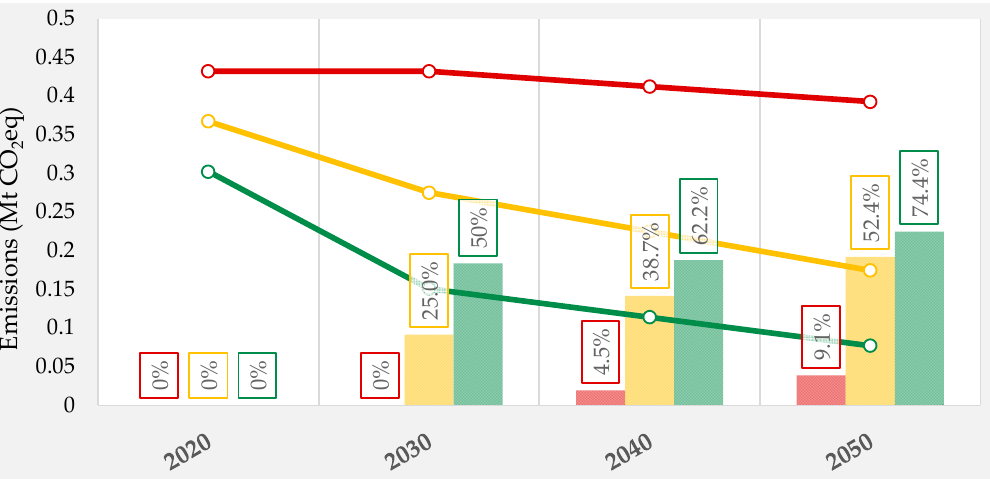
Figure 3. Biologicals’ global warming potential (GWP) vs. cost of goods (COGs) portfolio. Monoclonal antibody (mAb).